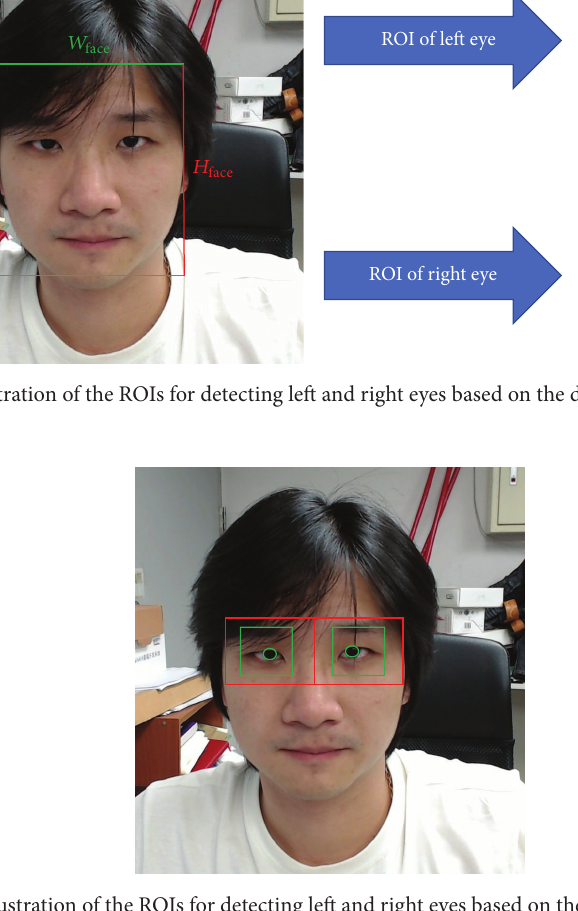
Figure 7: Illustration of the ROIs for detecting left and right eyes based on the detected eye